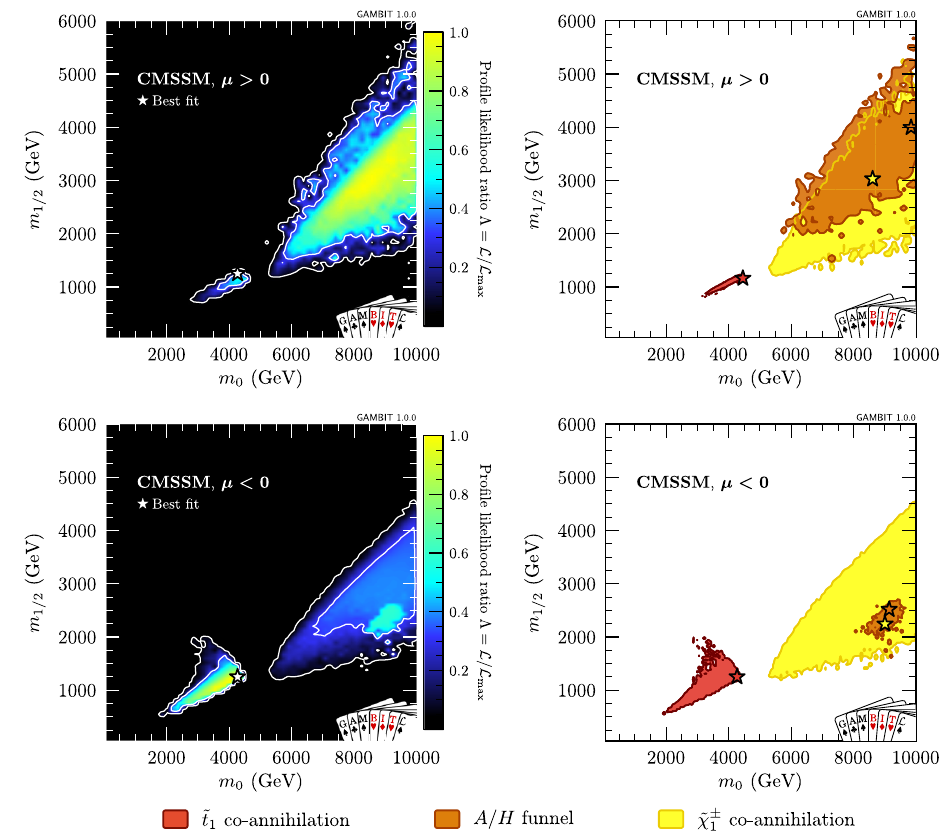
Fig. 3 Left: Profile likelihood ratio in the m 0 − m 1 / 2 plane of the CMSSM, for μ ≥ 0 (top) and μ < 0 (bottom). Right: Colour-coding